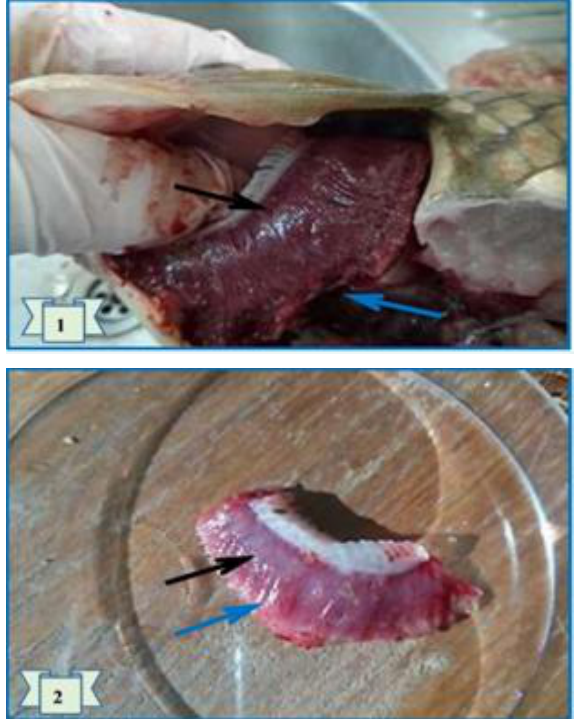
Figure, 6: Fungal Gill rot infection in common carp. Gross examination [1] showed sever congestion of gills with present of normal congested area (arrow) and other necrotic area (arrow), which known as [2] mosaic lesions consisted from white necrotic area (arrow) and other red normal appearance of gills (arrow).